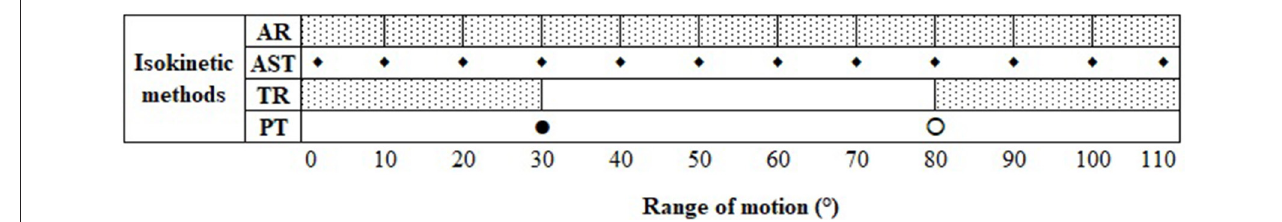
FIGURE 1 | Illustration of four isokinetic methods used to calculate agonist-antagonist ratios. Peak Torque (PT) method is the ratio between PT of agonist ( • ) and PT of antagonist ( (cid:13) ) independently of the angular position; Terminal Ranges (TR) method is the ratio between mean torque of agonist and antagonist at the 15 ◦ terminal ranges; Angle Specific Torque (AST) is the ratio between torque ( (cid:7) ) of agonist and antagonist at every 10 ◦ of the ROM; and Angular Ranges (AR) method is the ratio between mean torque of agonist and antagonist by angular range of 10 ◦ . The angles chosen in this illustration are